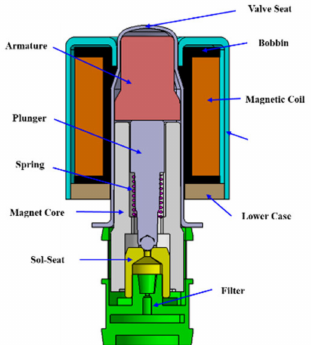
Figure 3. Schematic of the conventional TCV.